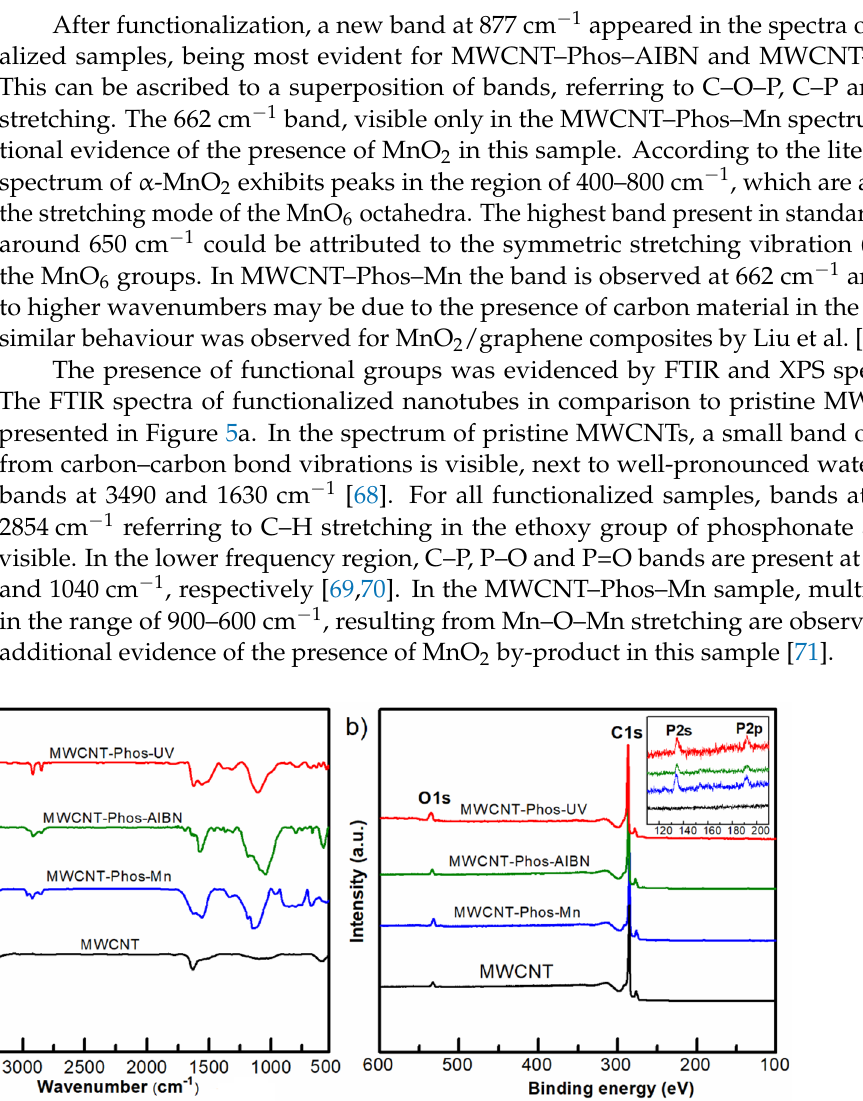
Figure 4. Raman spectra of pristine and functionalized MWCNTs. Table 2. Raman mode positions, linewidths (FWHM), and I D /I G ratios for MWCNT,